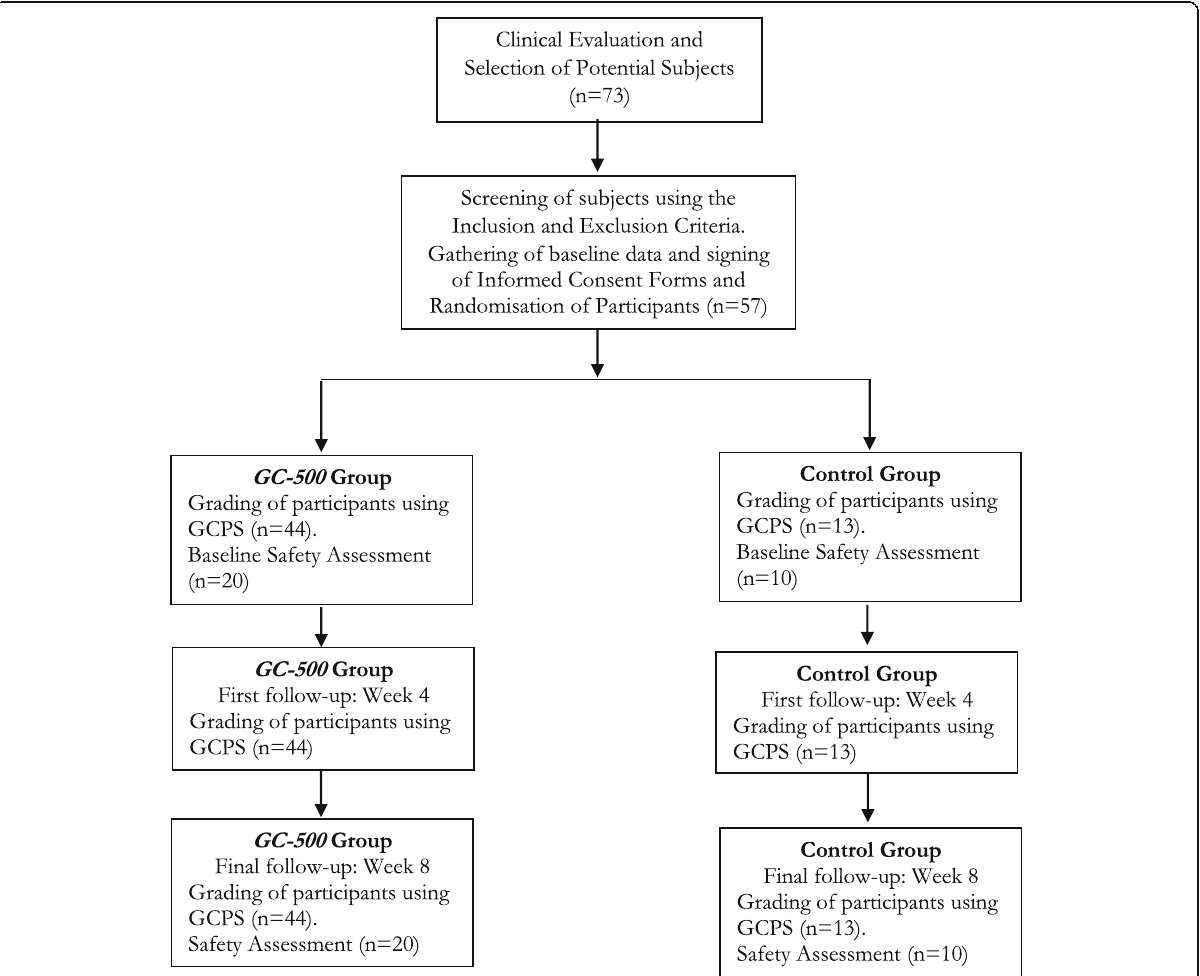
Fig. 1 Schematic representation of the sequence of activities participants were involved, randomisation groups for the